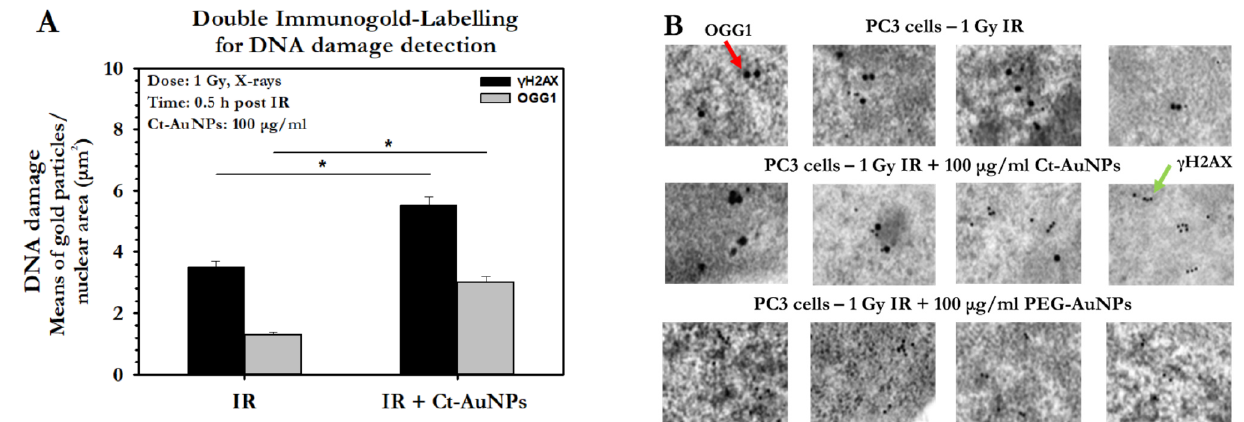
Figure 15. Formation of DSBs and oxidative lesions after treatment with AuNPs and X-ray irradiation. ( A ) Number of DSBs and 8-oxoguanine base lesions, induced after 1 Gy of IR exposure in PC3 cells, both with and without treatment with 100 μ g/mL Ct-AuNPs (15 nm). γ H2AX marker was used for the detection of DSBs and OGG1 was used for the detection of oxidative base lesions. Results indicate mean number of γ H2AX particles per nuclear area μ m 2 . Statistical significance was determined using Student t test: * p ≤ 0.05. ( B ) Electron micrographs indicating the increased formation of DNA damage clusters in PC3 cells, after gold-nanoparticle-induced radiosensitization. Red and green arrows point to the different sizes of immunogold particles depicting OGG1 (25 nm) and γ H2AX (10 nm) markers, respectively.